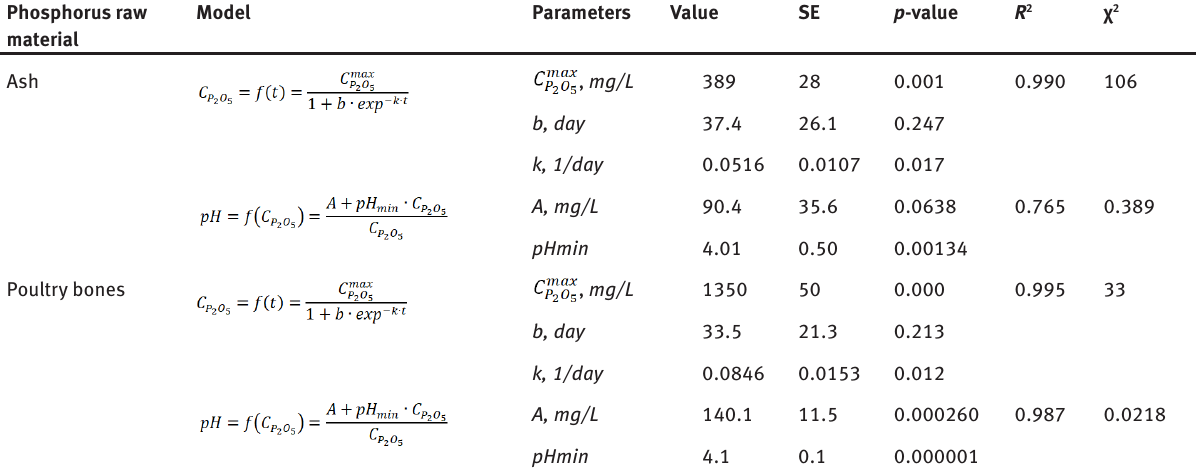
Table 1: Evaluated parameters of models: describing the kinetics of changes of concentration of P concentration during the solubilization